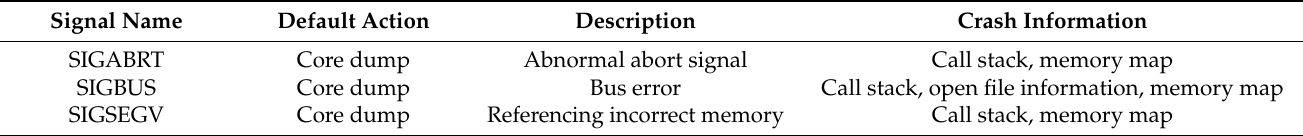
Table 3. Memory-related